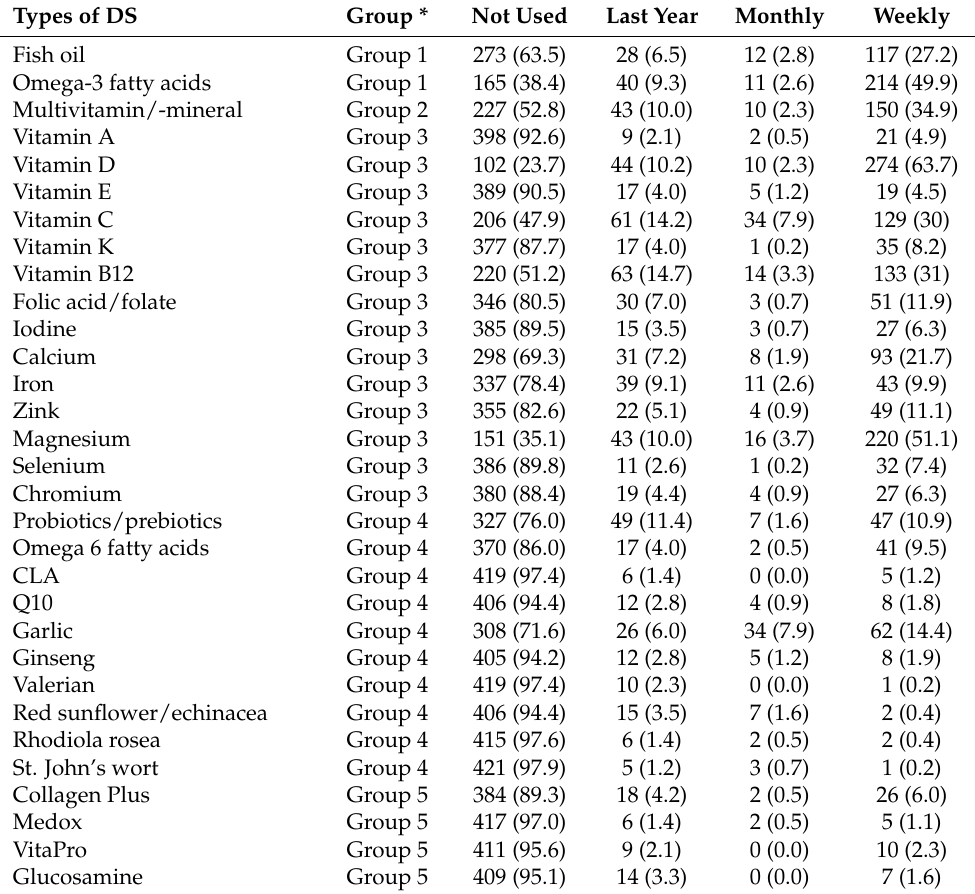
Table 2. Frequency (n) and percentage (%) of the use and non-use of various types of DS (registered users = 430).